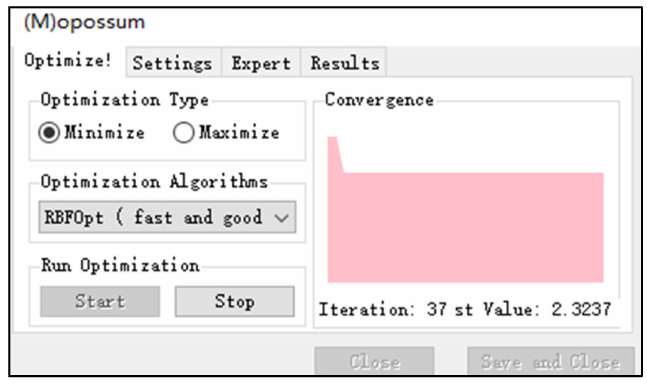
Figure 7. Schematic diagram of the running process of the component.